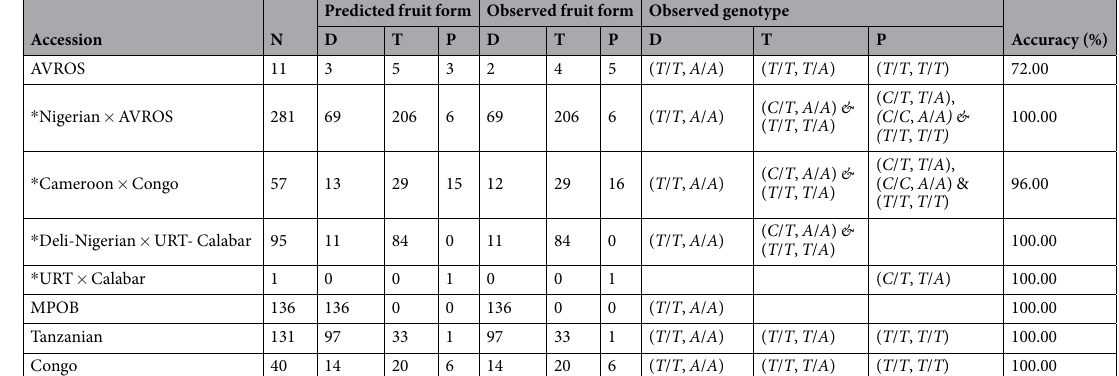
Table 2. The prediction accuracy of fruit form based on haploinsufficiency model and genotypes of assayed samples. The global accuracy of the second validation set = 99.34%. * Prediction accuracy based on functional copy (haploinsufficiency effect); N – number of samples; D – dura ; T – tenera ; P – pisifera . For (M1, M2), both T / T and A / A are sh Deli Dura / sh Deli Dura as wild type; M1 - T / C and C / C are sh Deli Dura / sh MPOB and sh MPOB / sh MPOB ; M2 - T / A and T / T are sh Deli Dura / sh AVROS and sh AVROS / sh AVROS .